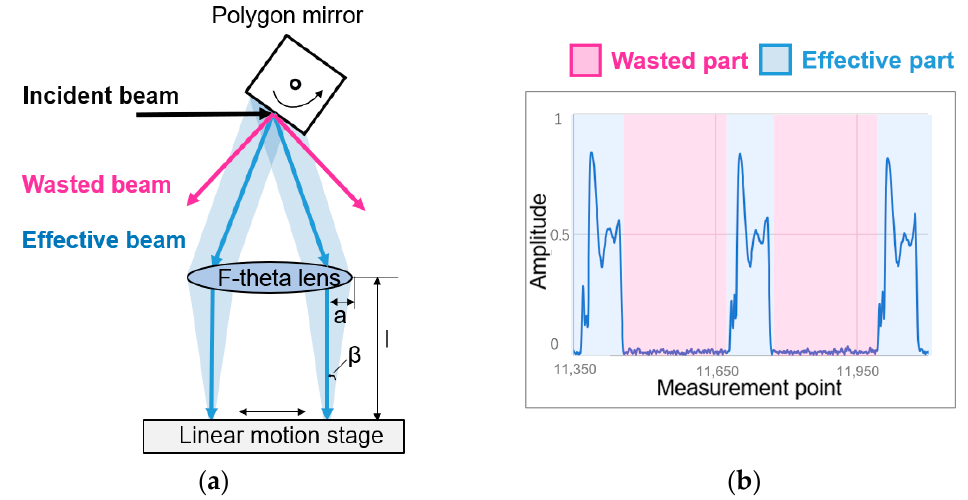
Figure 1. ( a ) Schematic diagram of the beam reflected by the polygon mirror. ( b ) Part of the 1D imaging data was collected using the polygon mirror.